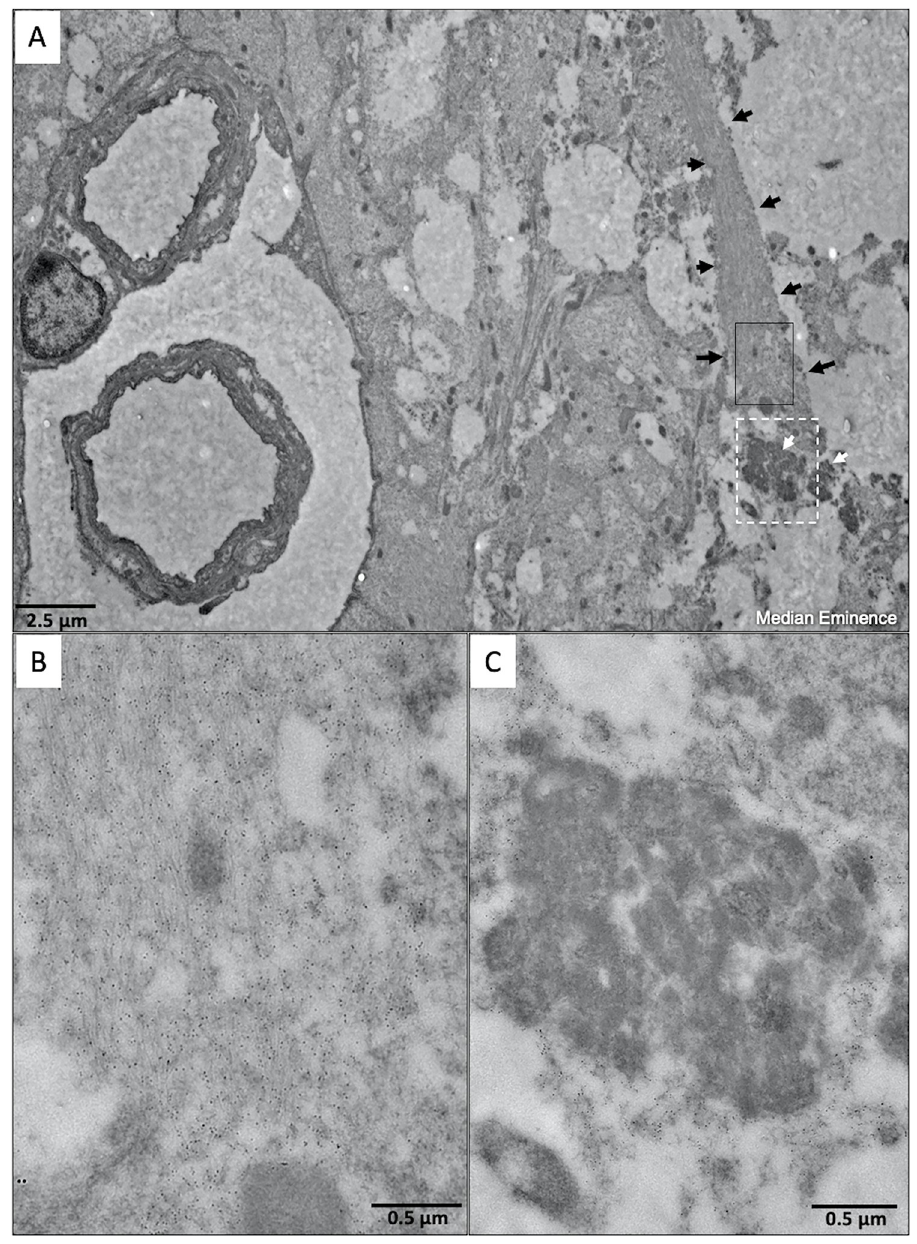
Fig 4. Representative immuno-electron microscopy at the border of median eminence region of medio-basal hypothalamus in a proestrous cow after intravenous kisspeptin administration. A) black arrows indicate synaptic terminals kisspeptin fiber projection, and white arrows indicate neurosecretory GnRH granules in axon terminals; B) Higher magnification from Fig A (black box) showing kisspeptin immunoreactive axon fiber projection is identified with gold particles (small black dots); C) Higher magnification from Fig A (dotted white rectangle) showing GnRH immunoreactive axon nerve terminal is identified with GnRH neurosecretory granules (DAB staining) surrounded by kisspeptin immunoreactivity (gold